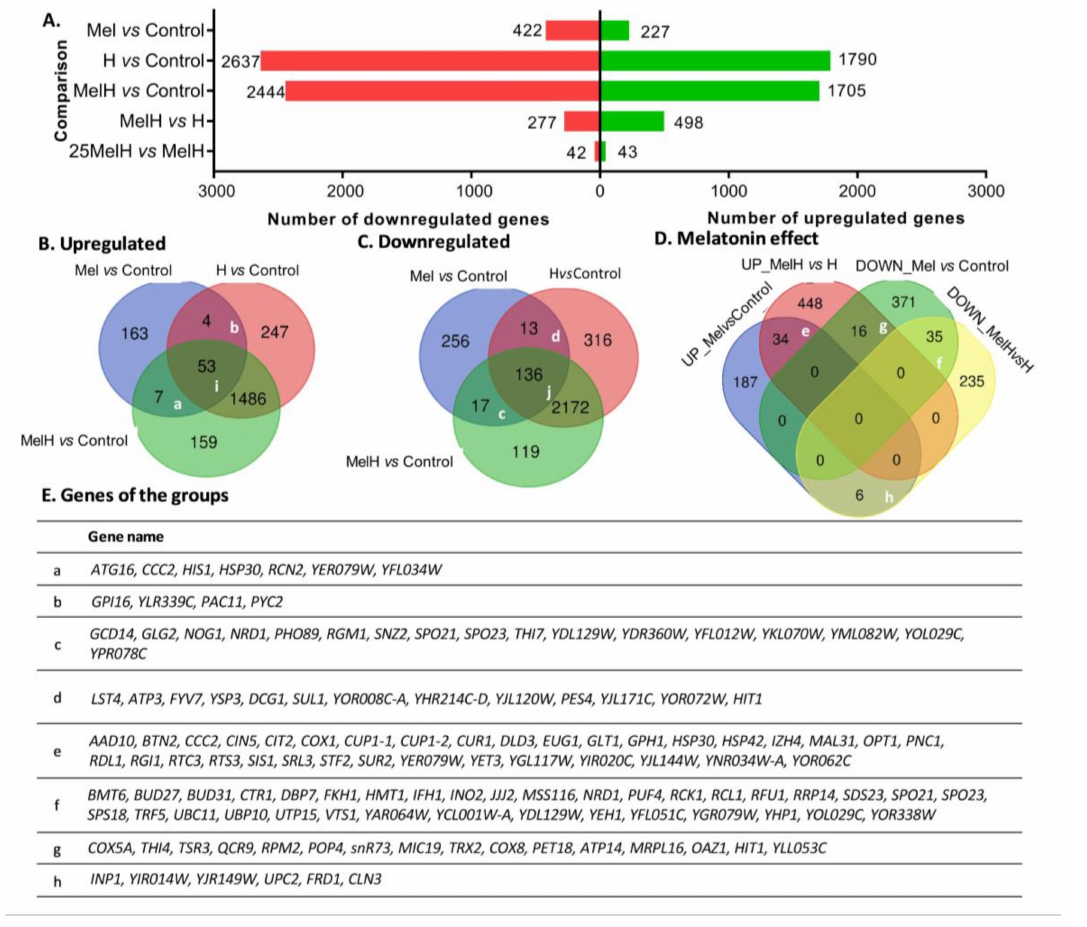
Figure 1. Distribution of di ff erentially expressed genes in yeast cells grown with and without melatonin (5 µ M or 25 µ M), in stressed (2 mM of H 2 O 2 ) and in unstressed conditions (Control, Mel, MelH, 25MelH and H). ( A ) The number of di ff erentially expressed genes between di ff erent conditions (fold change − 1 ≤ FC ≥ 1; p -value < 0.05). ( B , C ) Venn diagram showing the number of common genes found among the Mel vs. Control, MelH vs. Control and h vs. Control comparisons (up- ( B ) and down ( C ) regulated genes). ( D ) Venn diagram showing the number of common genes found among the up- and downregulated genes identified in the Mel vs. Control and MelH vs. h comparisons. ( E ) List of genes in some groups indicated in ( B – D ). The list of genes and the GO enrichment analysis of all the groups is shown in Table